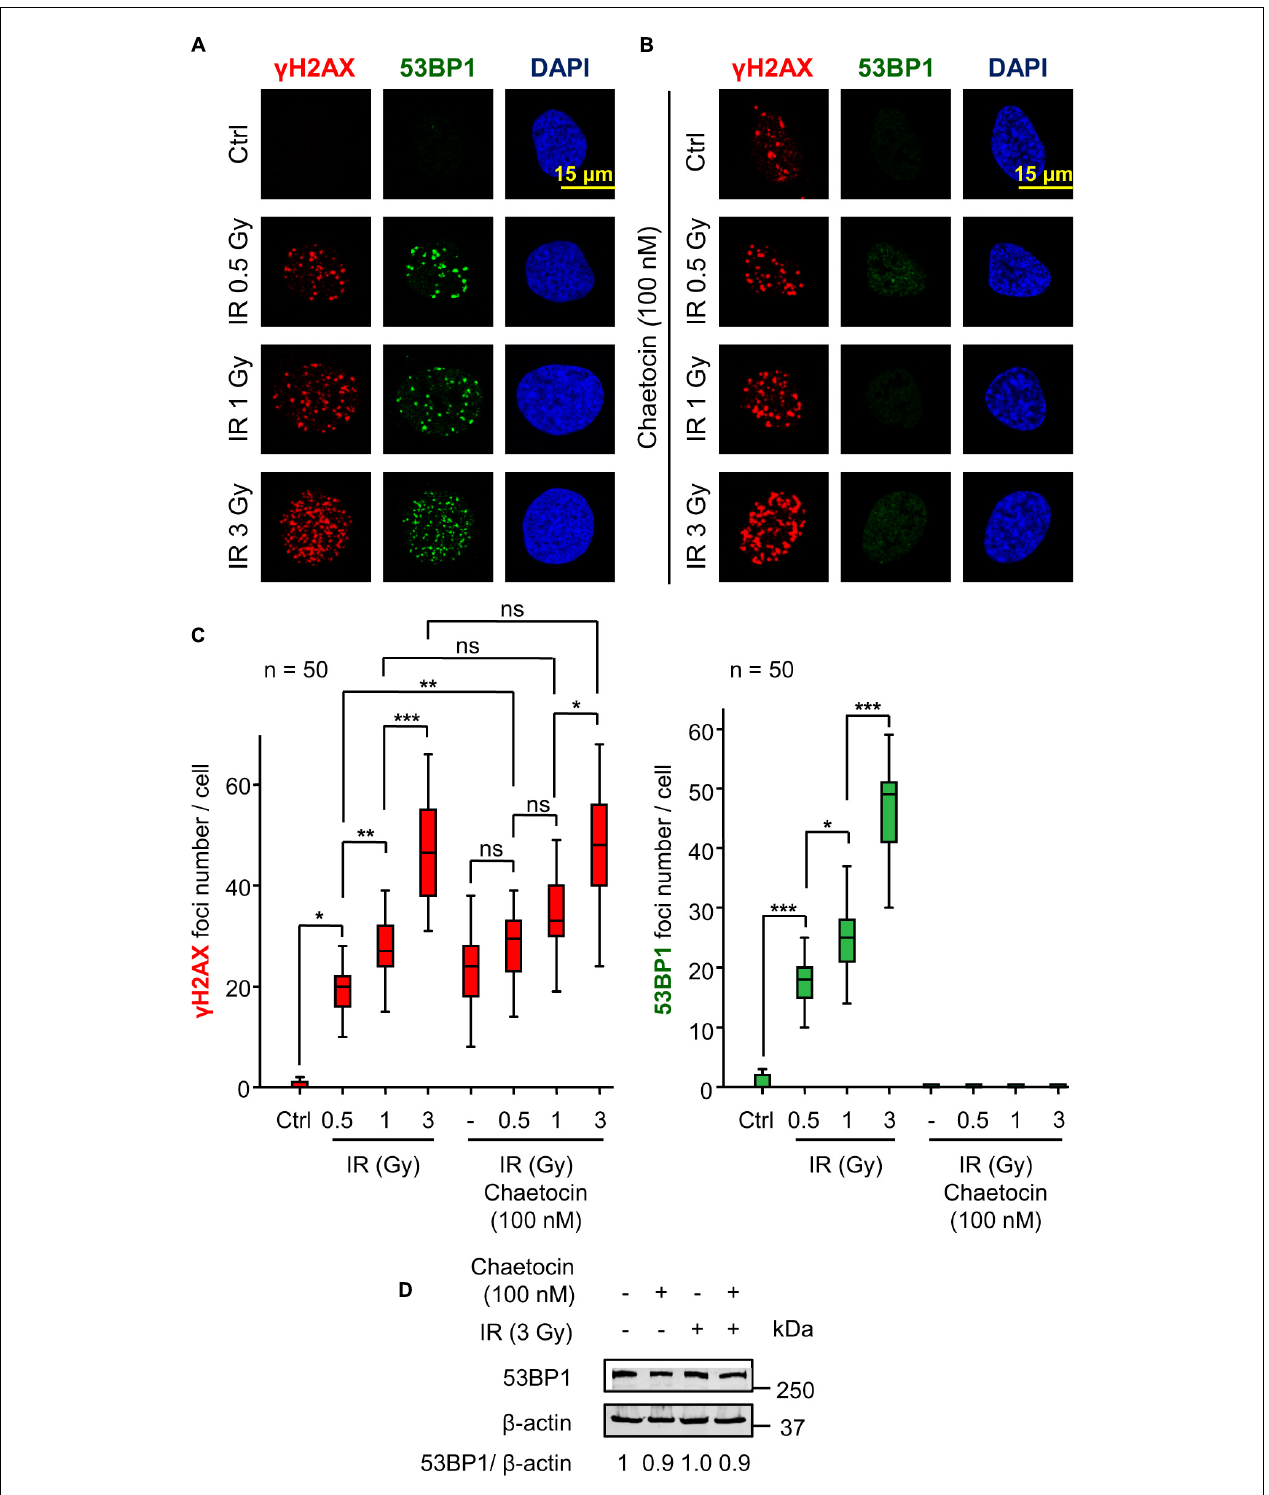
FIGURE 1 | Chaetocin impairs the assembly of 53BP1 foci in response to ionizing radiation (IR) in U2OS cells deprived of serum. (A) γ H2AX and 53BP1 foci formation in response to different doses of IR. (B) Effect of chaetocin on γ H2AX and 53BP1 foci formation after inducing DNA damage with different doses of IR. (C) Quantification of γ H2AX (left) and 53BP1 (right) foci in response to chaetocin and/or IR. (D) The immunoblot shows that chaetocin and/or IR have no effect on 53BP1 protein levels. ns, not significant. * p < 0.05, ** p < 0.01, and *** p < 0.001. These images only show the detail in one cell selected for presentation. The field images are shown in Supplementary Figure 1 . Ctrl, control without